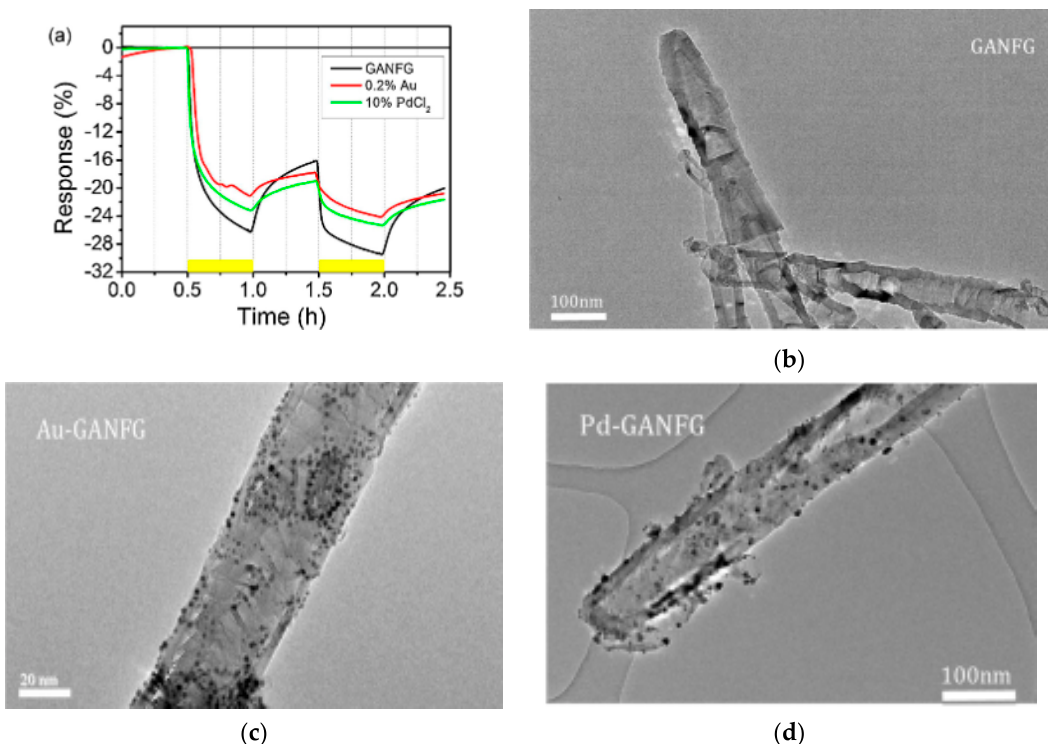
Figure 6. ( a ) Response of the sensors in the presence of 500 ppm NH 3 at 22 °C; TEM images of ( b ) raw carbon nanofibers (sample code was GANFG), and decorated ( c ) Au-GANFG and ( d ) Pd-GANFG samples [158]. With the permission of Elsevier.